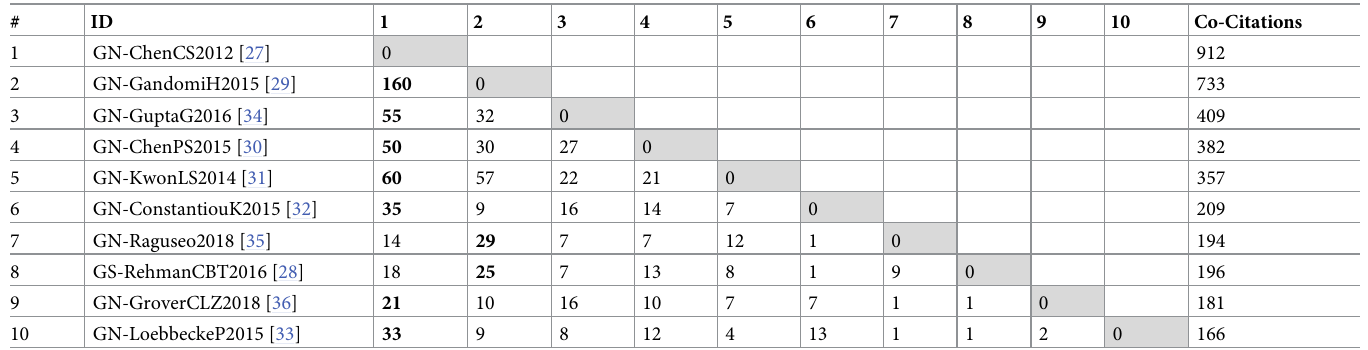
Table 2. Co-citation matrix of top 10 cross-referenced